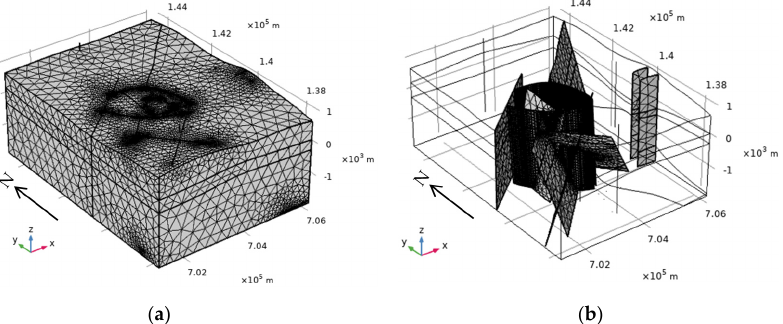
Figure 13. Model geometry: ( a ) top of the model; ( b ) bottom of the model. Energies 2020 , 13 , 3282